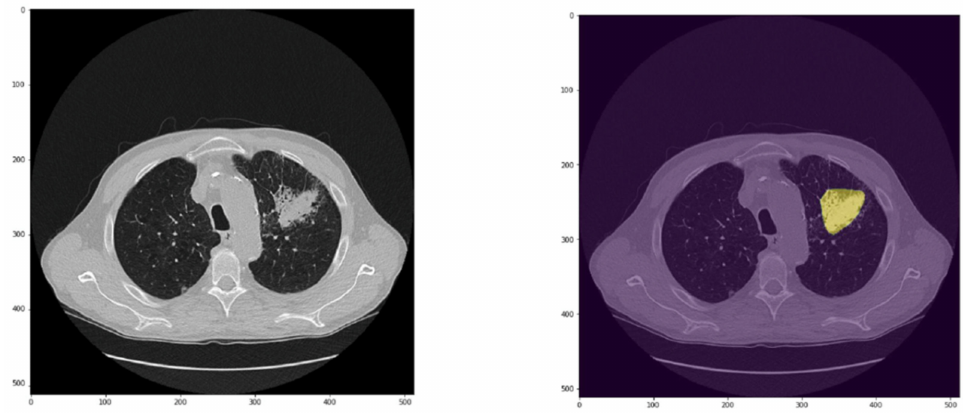
Figure 7. Example of a lesion of 55 mm (in yellow) wrongly predicted as malignant by the CADx.